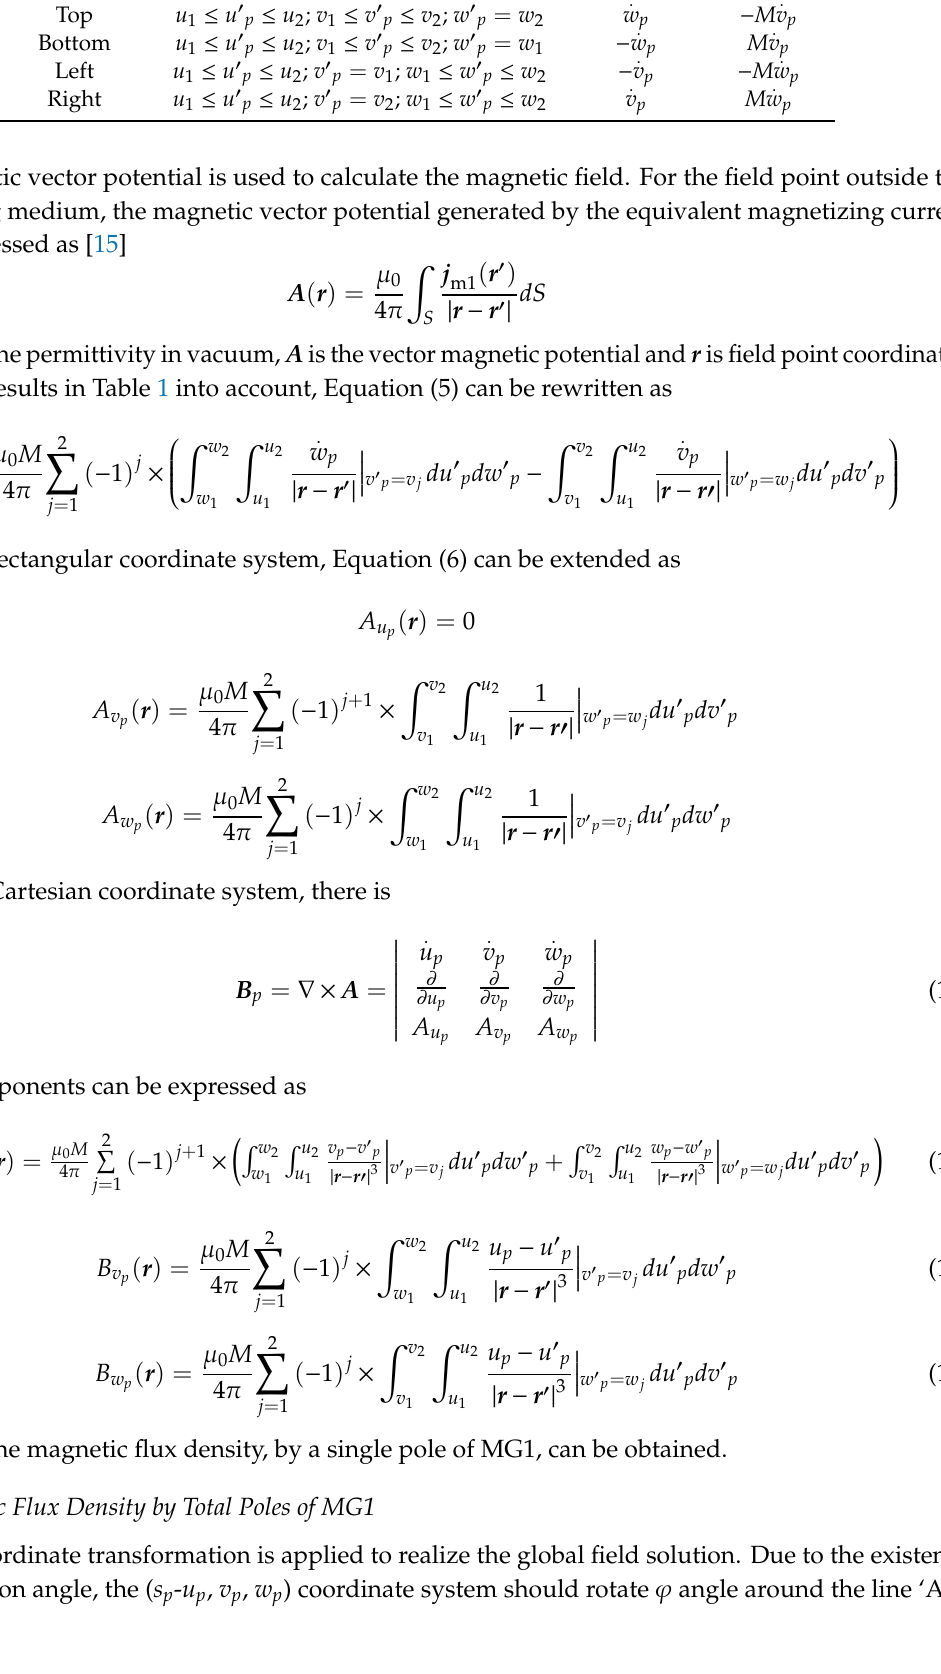
Table 1. Equivalent surface current of MG1 on the magnet’s surface. Surface Range n j